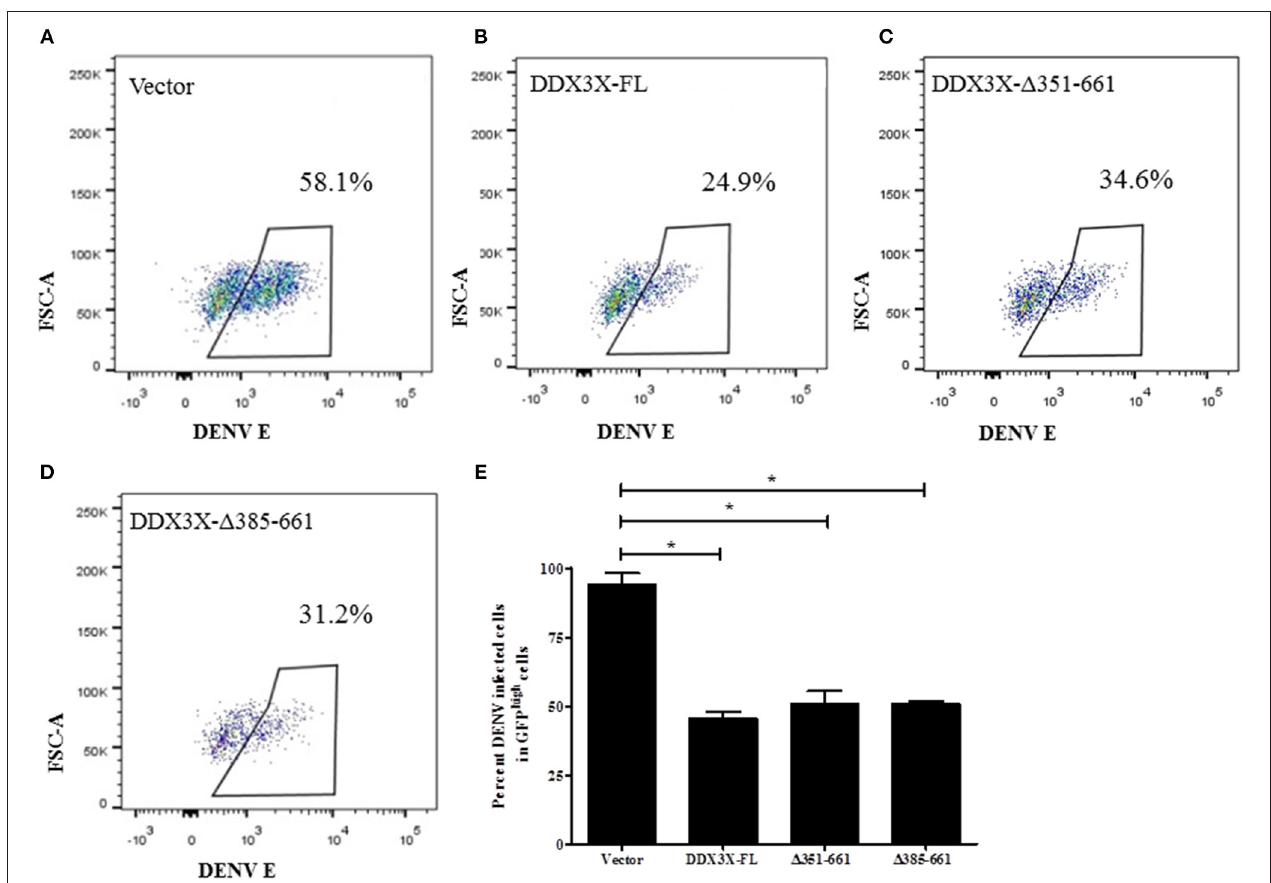
FIGURE 6 | Domain mapping of DDX3X antiviral activity. GFP tagged-DDX3X plasmids were transfected in HEK-293T cells and at 24h p.t, cells were infected with DENV at 5 MOI. Cells were fixed and stained at 24h pi with dengue envelope antibody. Cells were acquired in FACS and GFP signal was used to identify